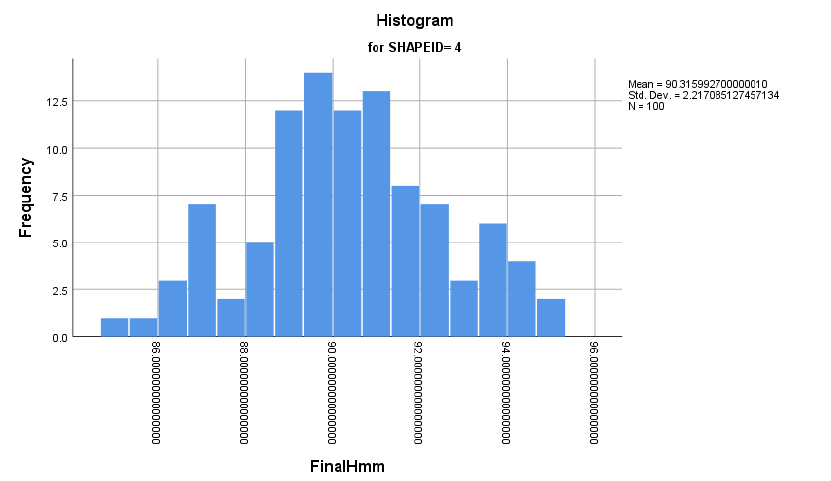
Figure A10. Grow height adjustment for 90 mm.